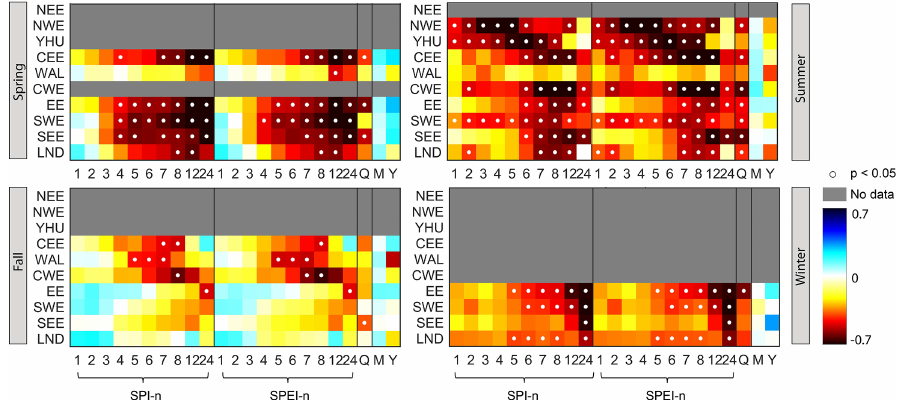
Figure 4. UK: rank correlation coefficients ( ρ ) between drought indicators and number of impact occurrences per NUTS1 region and